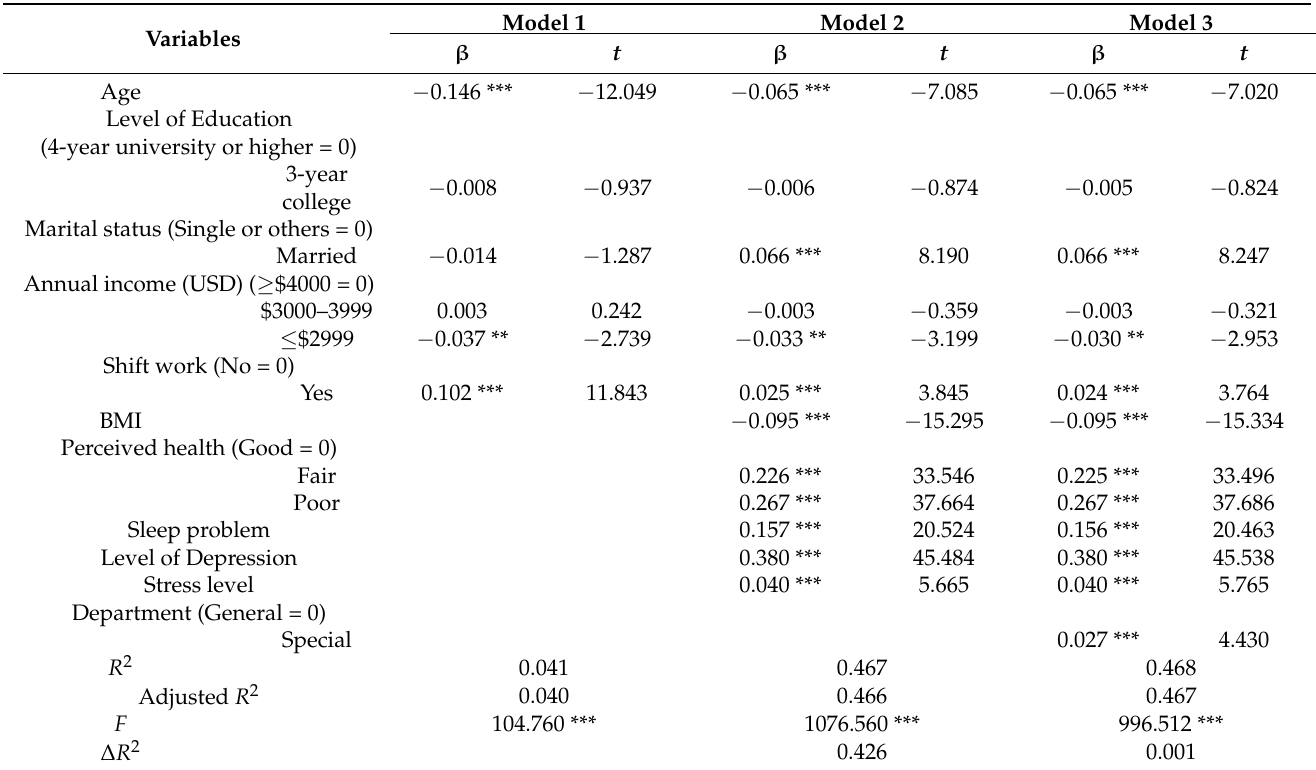
Table 2. Hierarchical multiple regression analysis predicting physical fatigue ( N =